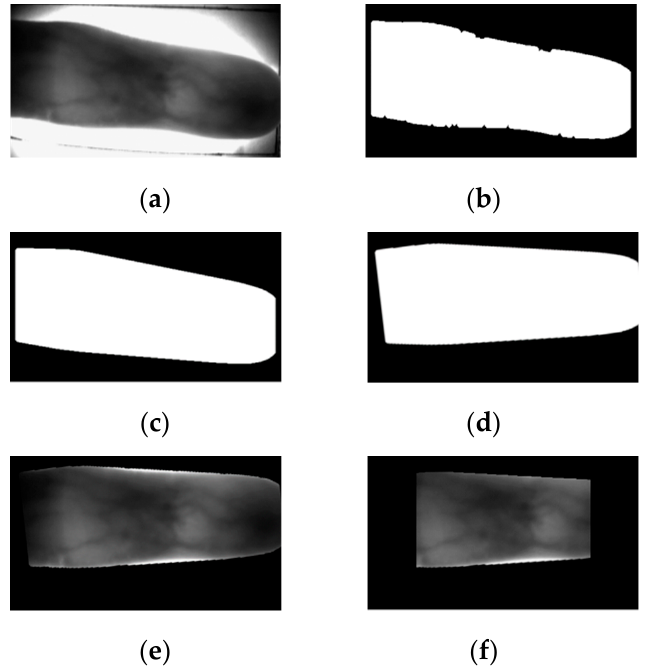
Figure 2. Sample images of each preprocessing stage: ( a ) original image, ( b ) image obtained after Sobel edge detection and thresholding, ( c ) image after edge smoothing, ( d ) image after in-plane rotation compensation, ( e ) finger-vein image obtained by region of interest (ROI) mask, and ( f ) finally cropped finger-vein ROI